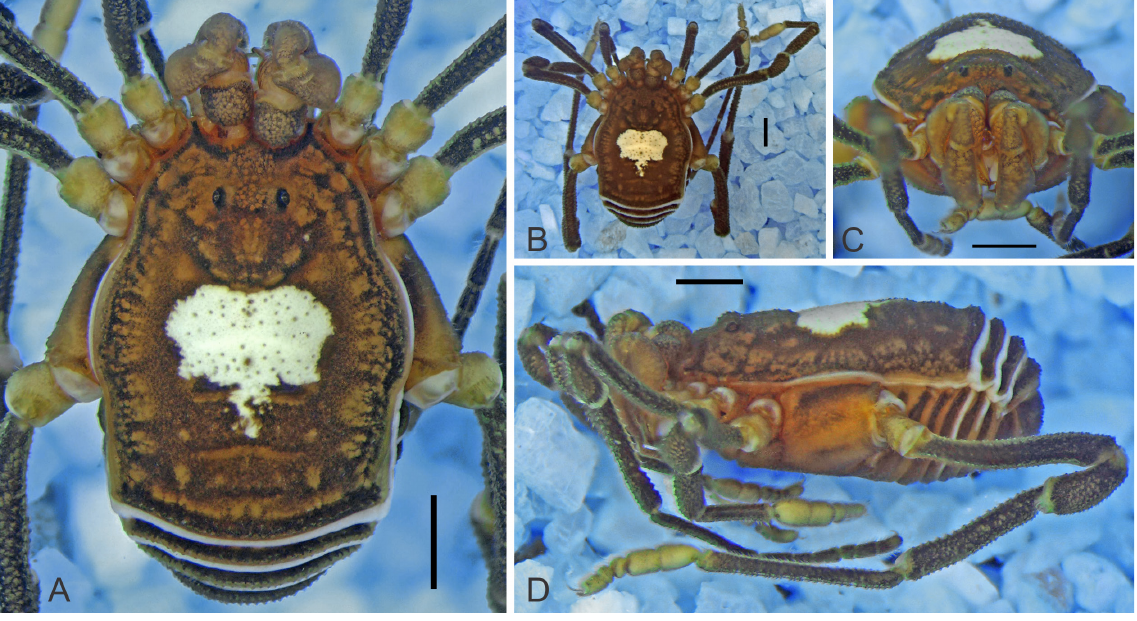
Fig. 5. Libitia cordata (Gervais, 1844), ♂ (ICN-AO 1040), habitus. A . Dorsal view. B . Dorsal view, panoramic. C . Frontal view. D . Lateral right view. Scale bars = 1